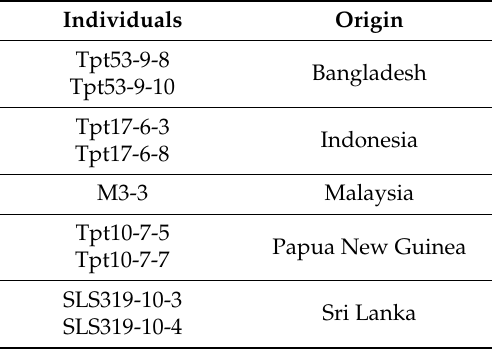
Table 1. Winged bean accessions (two individuals per origin, except Malaysian line) used and their origins.